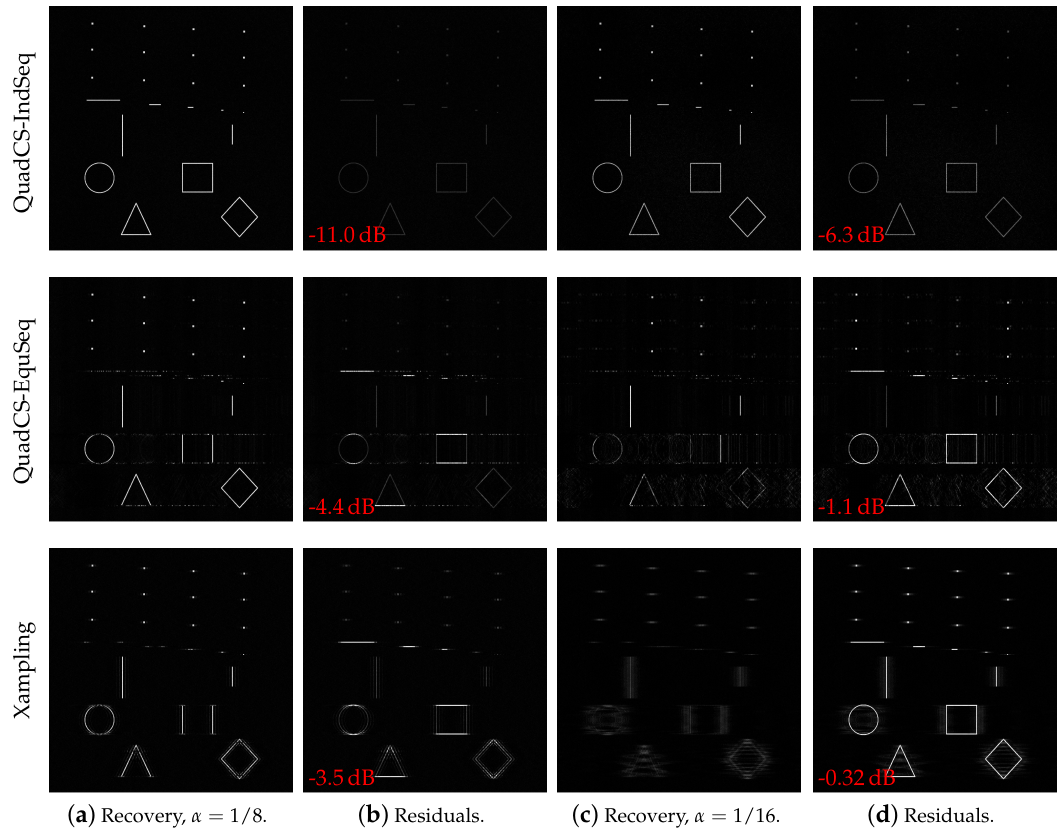
Figure 5. Recovery of the synthetic image in 10 dB AWGN. From top to bottom: QuadCS with independent chipping sequences (Quad-IndSeq), QuadCS with equal chipping sequences (Quad-EquSeq), Xampling. From left to right: recovered images and corresponding residuals with compression ratios 1/8 and 1/16. Range and azimuth are along the horizontal and vertical axes, respectively. The relative errors ( measured in dB) of these images are shown at the lower left corners of their residual images,